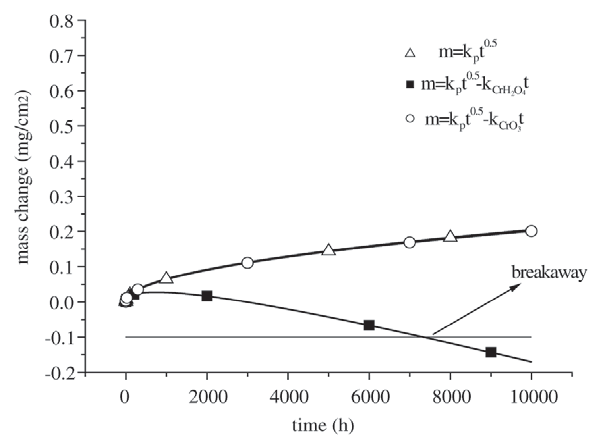
Figure 12. Results of mass change calculations as a function of time at 650 °C. The calculations are based on Eqs. 2 and